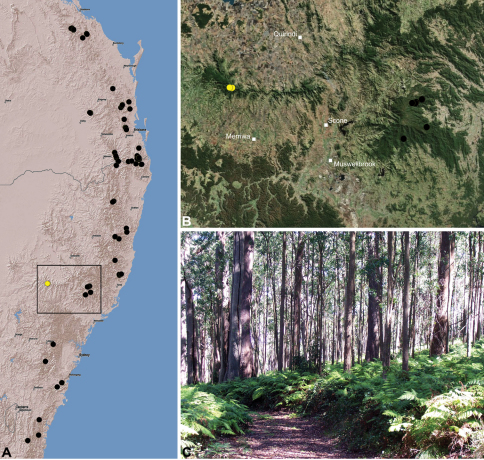
Austrarchaea mascordi sp. n., distribution and habitat: A, topographic map showing the known distribution of Archaeidae in south-eastern Queensland and eastern New South Wales, with collection localities for A. mascordi highlighted in yellow; B, satellite image showing detail of inset (A); C, open eucalypt forest near the type locality – Breeza Lookout, Coolah Tops National Park, New South Wales (April 2010). Image (C) by M. Rix.